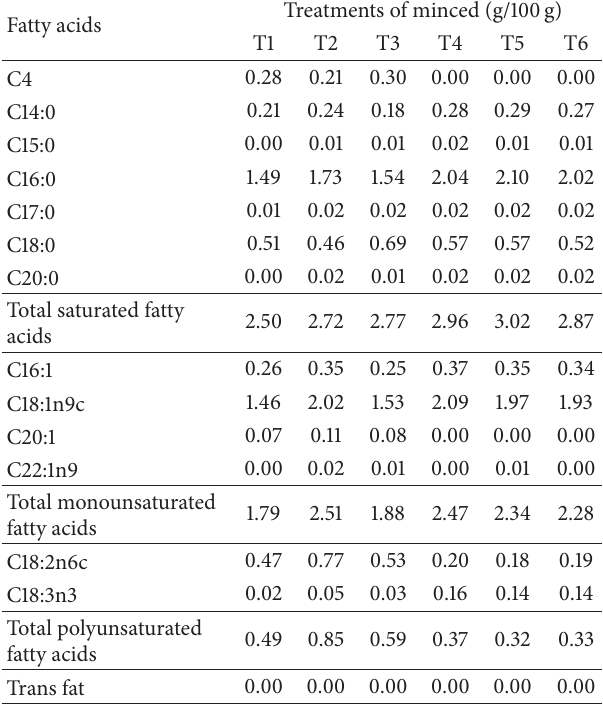
Table 2: Levels of proteins and lipids in the minced tilapia with respect to storage time.